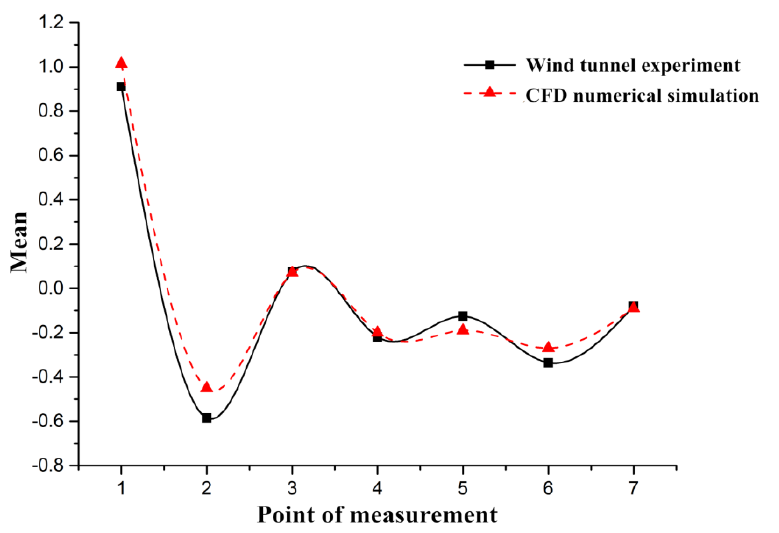
Figure 6. Pressure coefficient comparison.